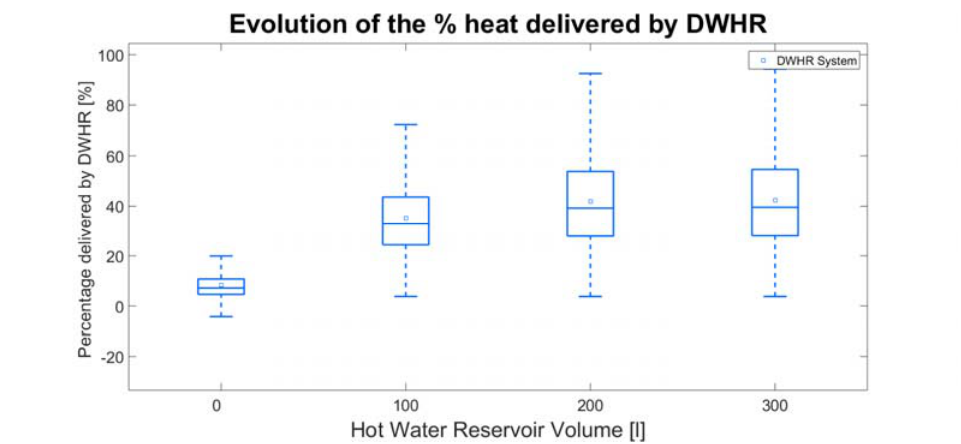
Figure 4. Evolution of the yearly average share of heat delivered by the DWHR system.